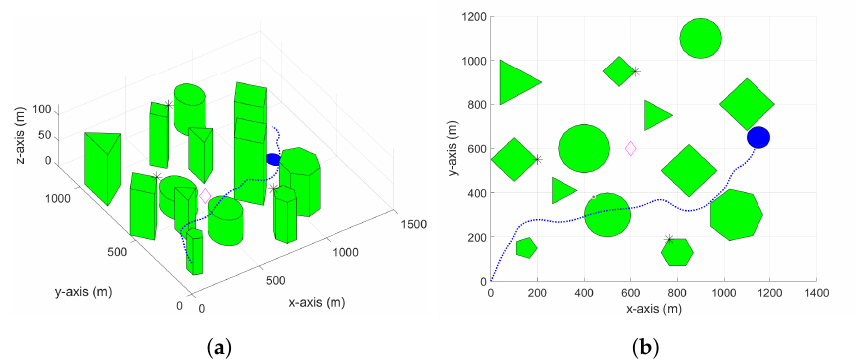
Figure 7. 3D ( a ) and 2D ( b ) views of the UAV trajectory by the compared